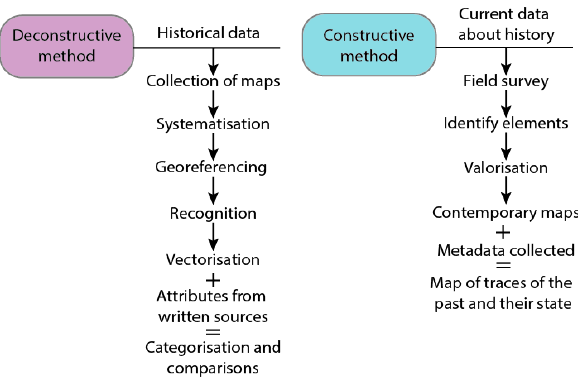
Figure 1 . Methodological structure and steps undertaken to perform the study. Source: Authors